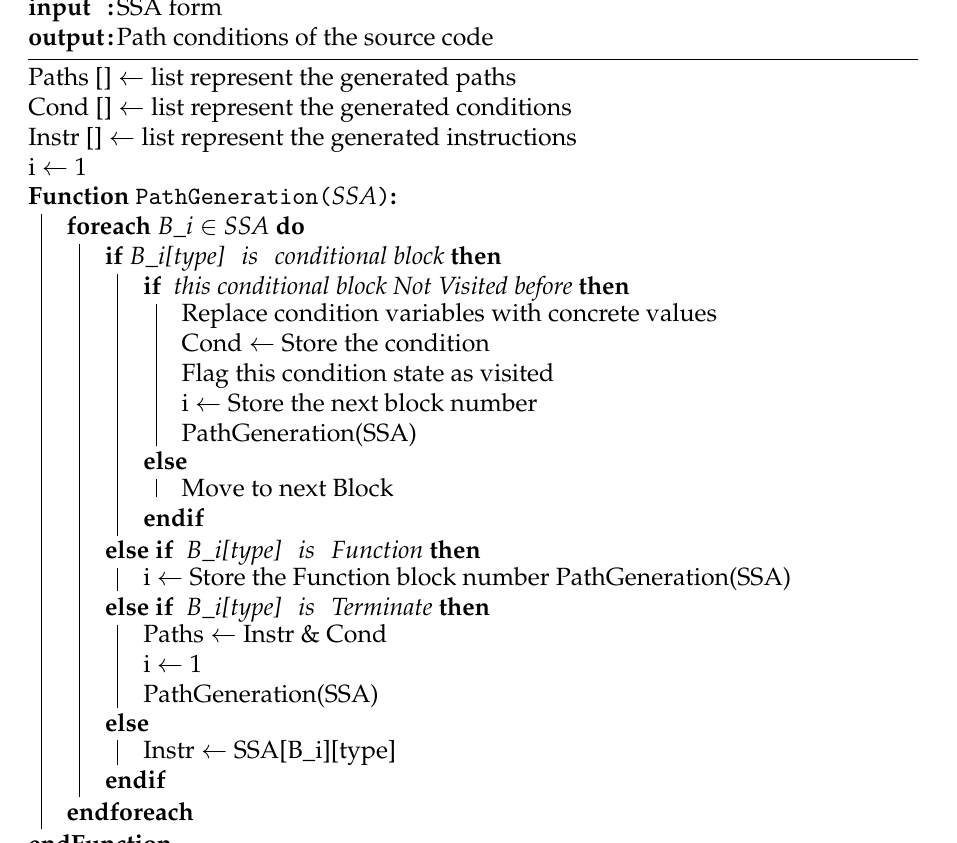
Algorithm 2: Path Generation and Constraints Extractor